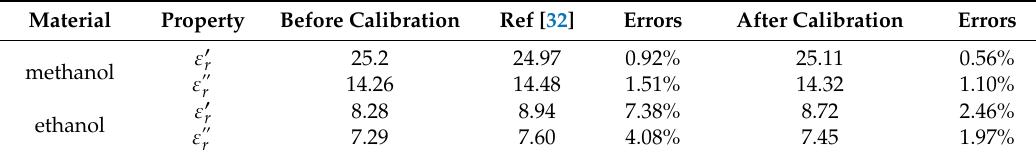
Table 3. Measurement results of methanol and ethanol.